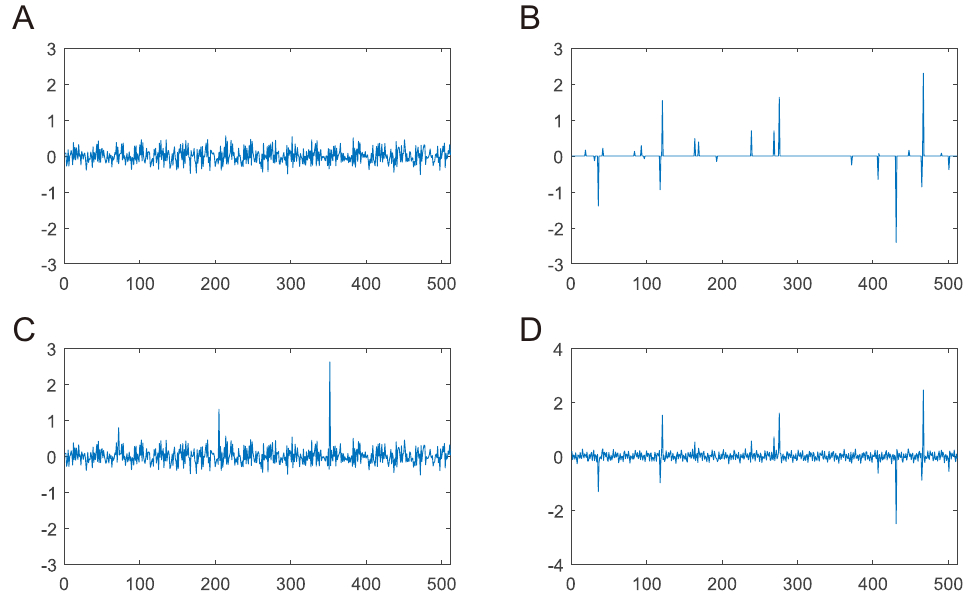
Figure 4. ( A ) Original signal( N = 512); ( B ) signal in sparse domain ( K = 25); ( C ) signal with abnormal events; ( D ) signal with abnormal events in sparse